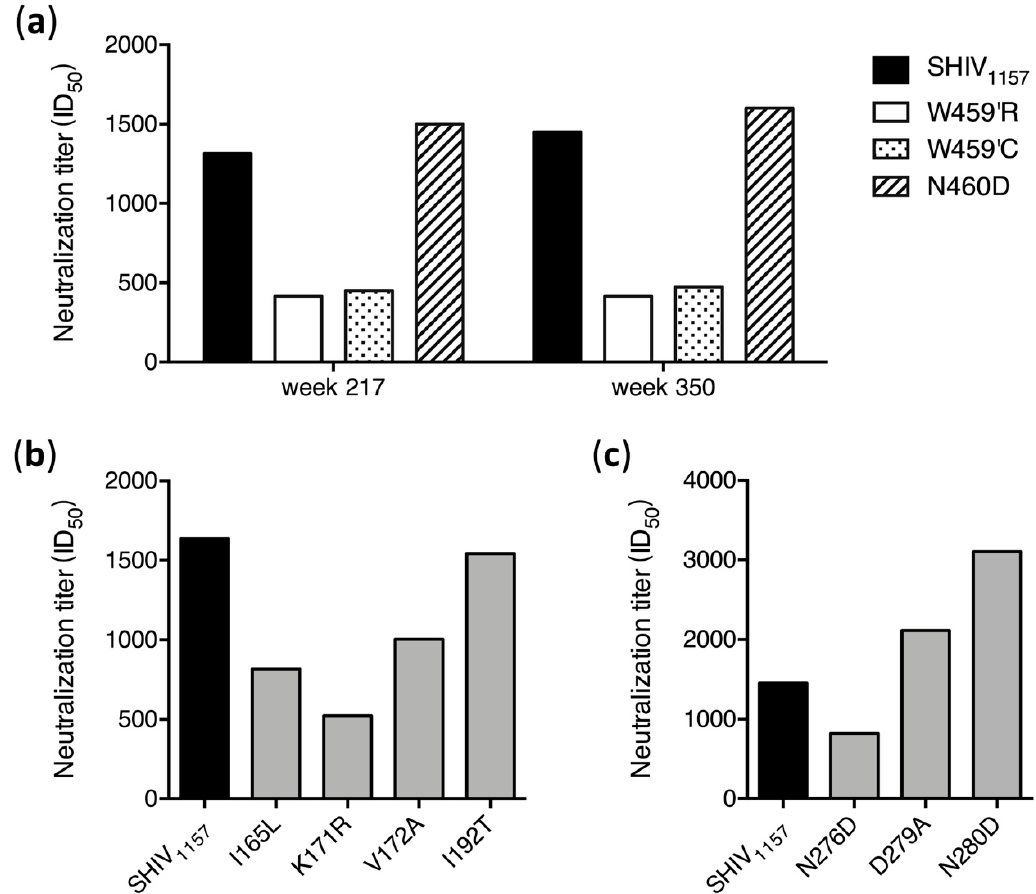
Figure 5. Neutralization susceptibility of escape mutants to autologous plasma. ( a ) Neutralization sensitivity of the env mutants with mutations in V5 was determined using the week 217 and week 350 plasma samples from G1015R. Neutralization sensitivities of the env mutants with mutations in V2 ( b ) and loop D ( c ) were determined using the week 350 plasma from G1015R.